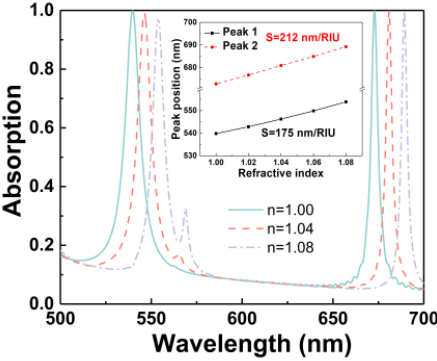
Figure 5. Absorption spectrum for a different background refractive index. Inset: the spectral position as a function of the background refractive index.